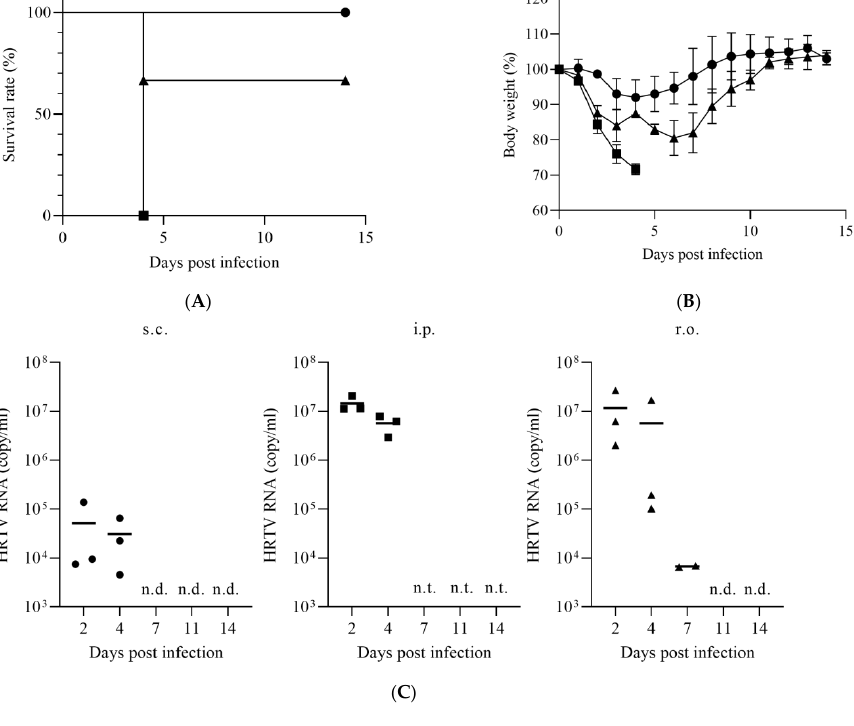
( D ) Figure 1. IFNAR − / − mice were infected with 1 × 10 7 TCID 50 of HRTV subcutaneously (closed circles), intraperitoneally (closed squares), or retro-orbitally (closed triangles). ( A ) Survival rate of the in- fected IFNAR −/− mice ( n = 3). ( B ) Sequential changes in bodyweights of IFNAR −/− mice ( n = 3). Relative weights were calculated and are shown as means with standard deviations. ( C ) The copy numbers of HRTV RNA in blood samples collected from the infected IFNAR −/− mice on days 2, 4, 7, 11, and 14 postinfection ( n = 3). n.d.: not determined. n.t.: not tested. ( D ) Comparison of levels of HRTV RNA between IFNAR −/− mice that survived and those that died of HRTV infection. The white box and gray box indicate the HRTV RNA levels of the mice that survived and those that reached the endpoint, respectively. Significance was determined by Mann – Whitney test. * p < 0.05. To determine the 50% lethal dose (LD 50 ) of HRTV in IFNAR −/− mice when infected intraperitoneally, the IFNAR −/− mice were inoculated intraperitoneally with HRTV at doses of 1 × 10 4 , 1 × 10 5 , 1 × 10 6 , or 1 × 10 7 TCID 50 . The survival rate, sequential change in weight, and clinical signs were observed for 11 days postinoculation. IFNAR −/− mice in- fected with 1 × 10 7 TCID 50 of HRTV showed severe weight loss, ruffled fur, and hunched postures, and they died within 4 days postinfection (Figure 2A,B). In contrast, IFNAR −/− mice infected with 1 × 10 4 , 1 × 10 5 , and 1 × 10 6 TCID 50 of HRTV showed no obvious clinical signs, except for slight weight loss, and they survived (Figure 2A,B). The LD 50 of HRTV to IFNAR −/− mice when infected intraperitoneally was calculated to be 3.2 × 10 6 TCID 50 . The mean copy numbers of the HRTV RNA in the blood of IFNAR −/− mice infected with 1 × 10 4 , 1 × 10 5 , 1 × 10 6 , and 1 × 10 7 TCID 50 of HRTV at 2 days postinfection were 3.4 × 10 3 , 5.7